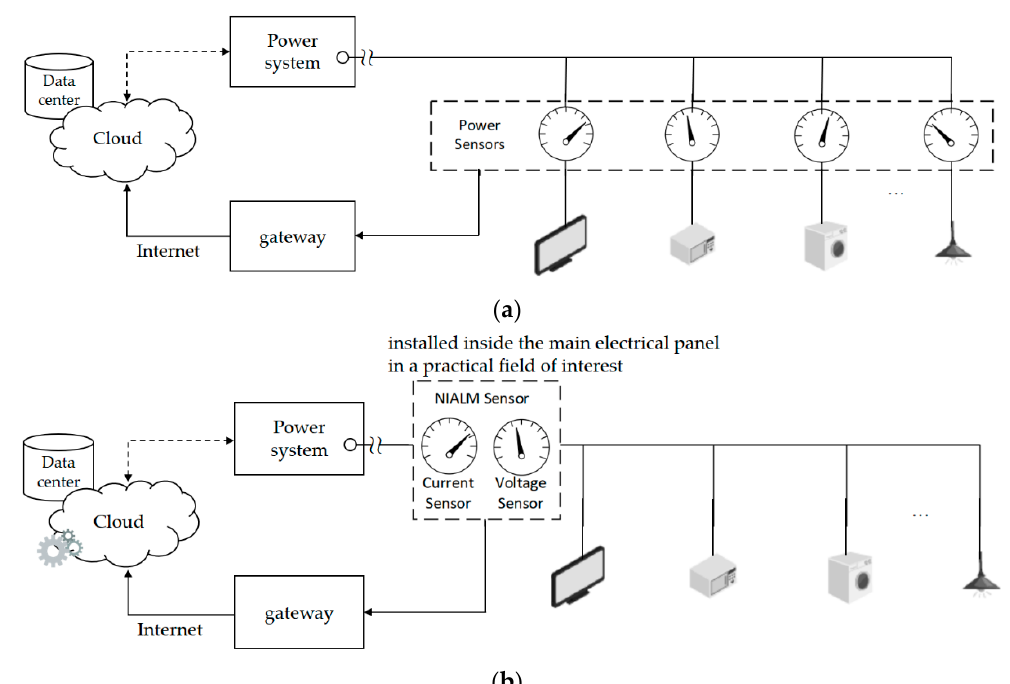
Figure 1. Appliance load monitoring approaches: ( a ) Intrusive appliance load monitoring (IALM); ( b ) non-intrusive appliance load monitoring (NIALM). Besides IALM, NIALM conducted in a practical field of interest such as a smart house can draw several inferences such as appliance-level energy consumption from total (circuit-level) energy consumption acquired by only one minimal set of plug-panel current and voltage sensors (or alternatively retrieved from a single source such as a power utility-owned smart meter [21,22]) instead of deployed and installed plug-load power meters (smart plugs) for relevant individual electrical appliances.